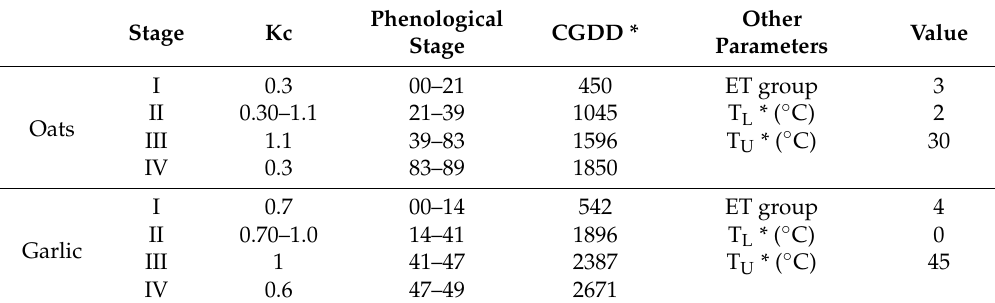
Table 3. Crop parameter values used by Irrigation Scheduling—MOPECO software for oats and garlic